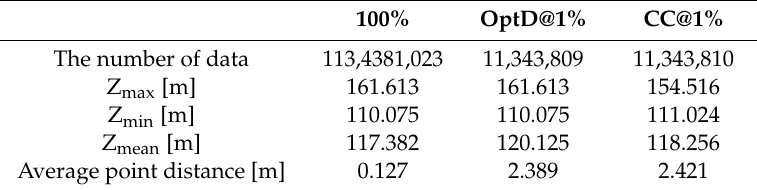
Table 1. Characteristics of the MLS dataset before and after data reduction.